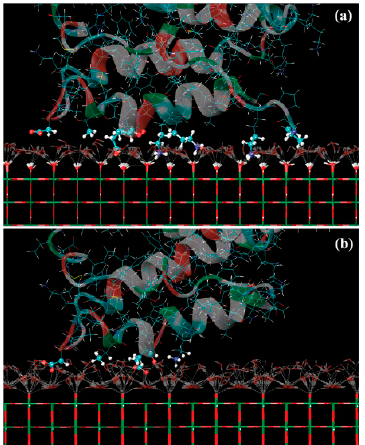
Figure 10. Snapshots of adsorption residues on ( a ) hydroxylated and ( b ) nonhydroxylated TiO 2 surfaces. Only the interfacial water molecules with the hydrogen bond network are shown and are displayed as white dashed lines. Reprinted from Ref. [127] with permission from American Chemistry Society.